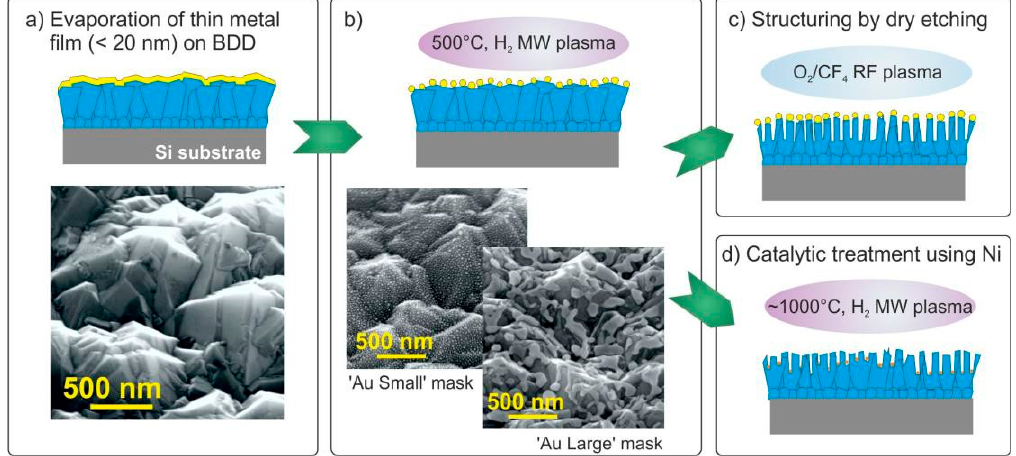
Figure 1. Schematic drawing of fabrication process of structured boron-doped diamond films and corresponding surface morphology of as-grown BDD film and BDD films with two types of gold nanocluster’s masks (i.e., tilted-angle SEM images of BDD films with gold masks labelled as ‘Au small’ and ‘Au large’ with initial thickness of evaporated Au of 3 nm and 12 nm, respectively, after annealing). The fabrication process includes: ( a ) evaporation of thin metal film, ( b ) annealing (in hydrogen-plasma) to form metal clusters, and ( c ) reactive ion etching using O 2 /CF 4 gas mixture or ( d ) catalytic thermal treatment using microwave plasma in hydrogen